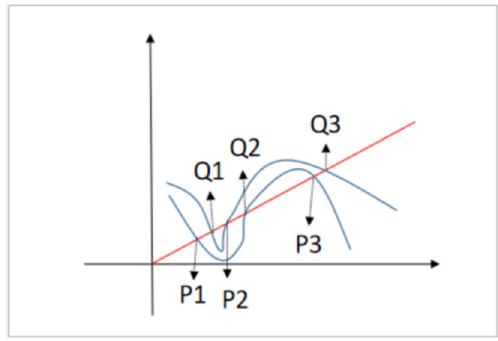
Figure 8. Selection of the corresponding point pairs.